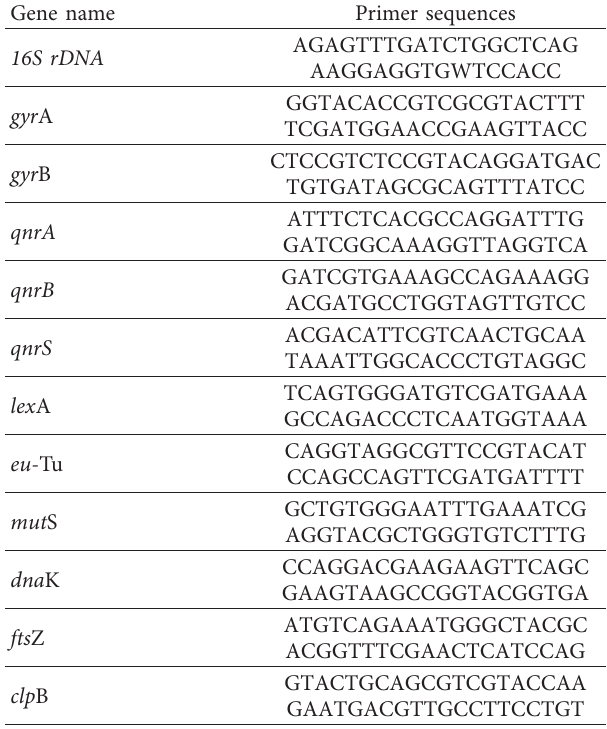
Table 1: Sequence details of various primers used in the